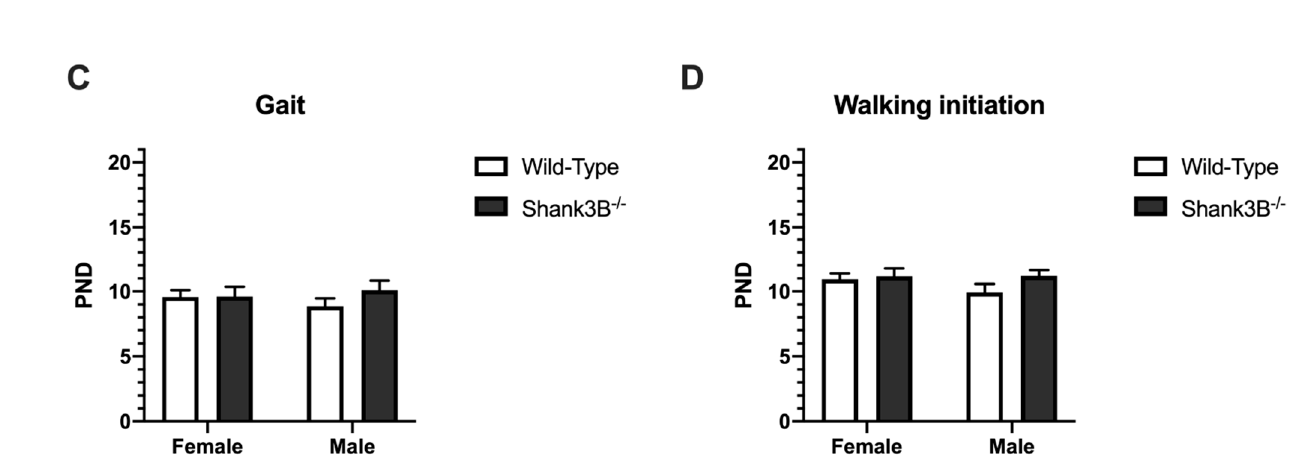
Figure 5. Motor skills. ( A ) Negative geotaxis in females. ( B ) Negative geotaxis in males ( C , D ) Gait and walking initiation, respectively. PND = postnatal day; * denotes p < 0.05, ** denotes p < 0.01 and *** denotes p < 0.001. Data are shown as mean + SEM. Shank3B − / − : ♀ n = 13, ♂ n = 10; Wild-Types: ♀ n = 29, ♂ n = 15.